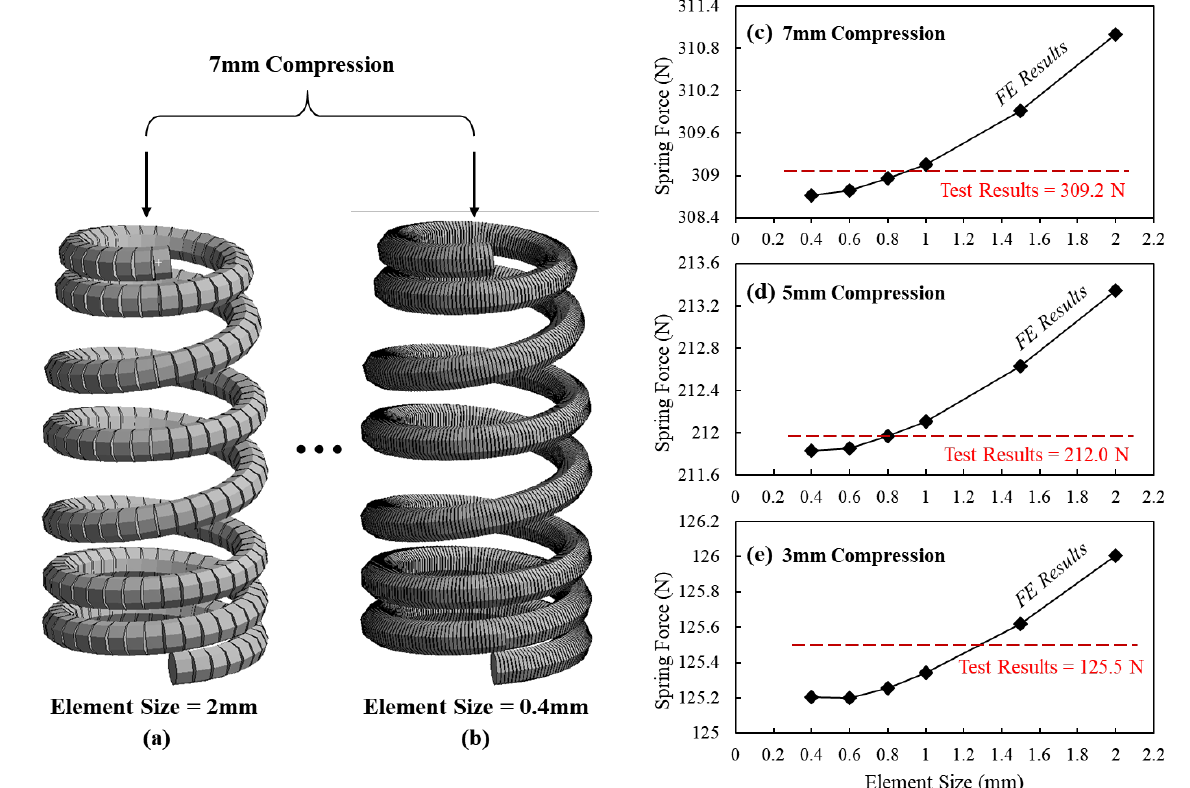
Figure 3. The FE models of beehive spring with ( a ) 2 mm and ( b ) 0.4 mm element sizes and the convergency study of the size of elements at ( c ) 7 mm, ( d ) 5 mm and ( e ) 3 mm compressions.